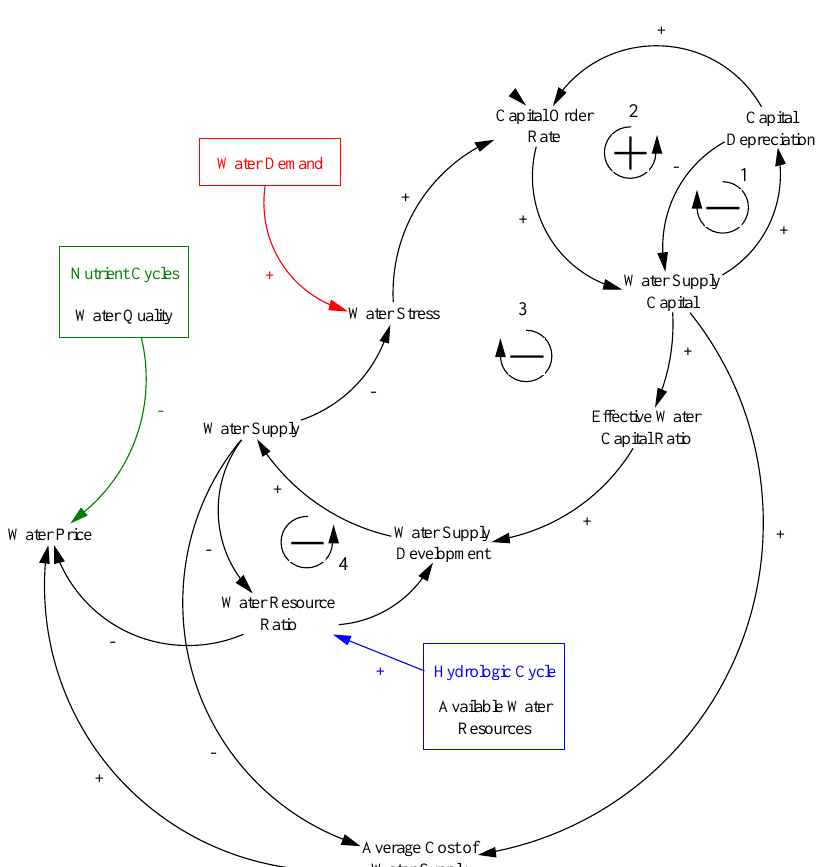
Figure 2. Causal loop diagram of the ANEMI3 water supply development sector. The dotted arrow from water price to water supply indicates a causality that is neither positive nor negative. Different colors identify inputs coming from different model sectors. Clockwise arrow with − sign designates negative feedback loop and counter clockwise arrow with + sign designates positive feedback loop.